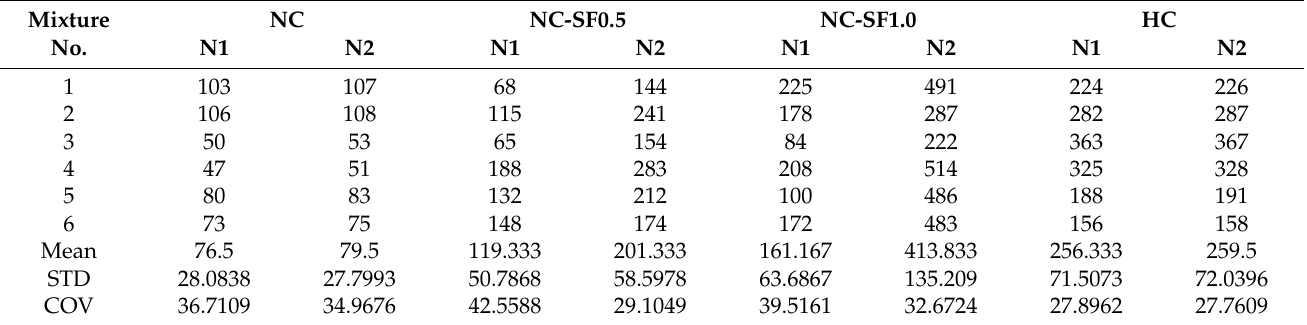
Table 2. Cracking and failure impact numbers of Batch 1.